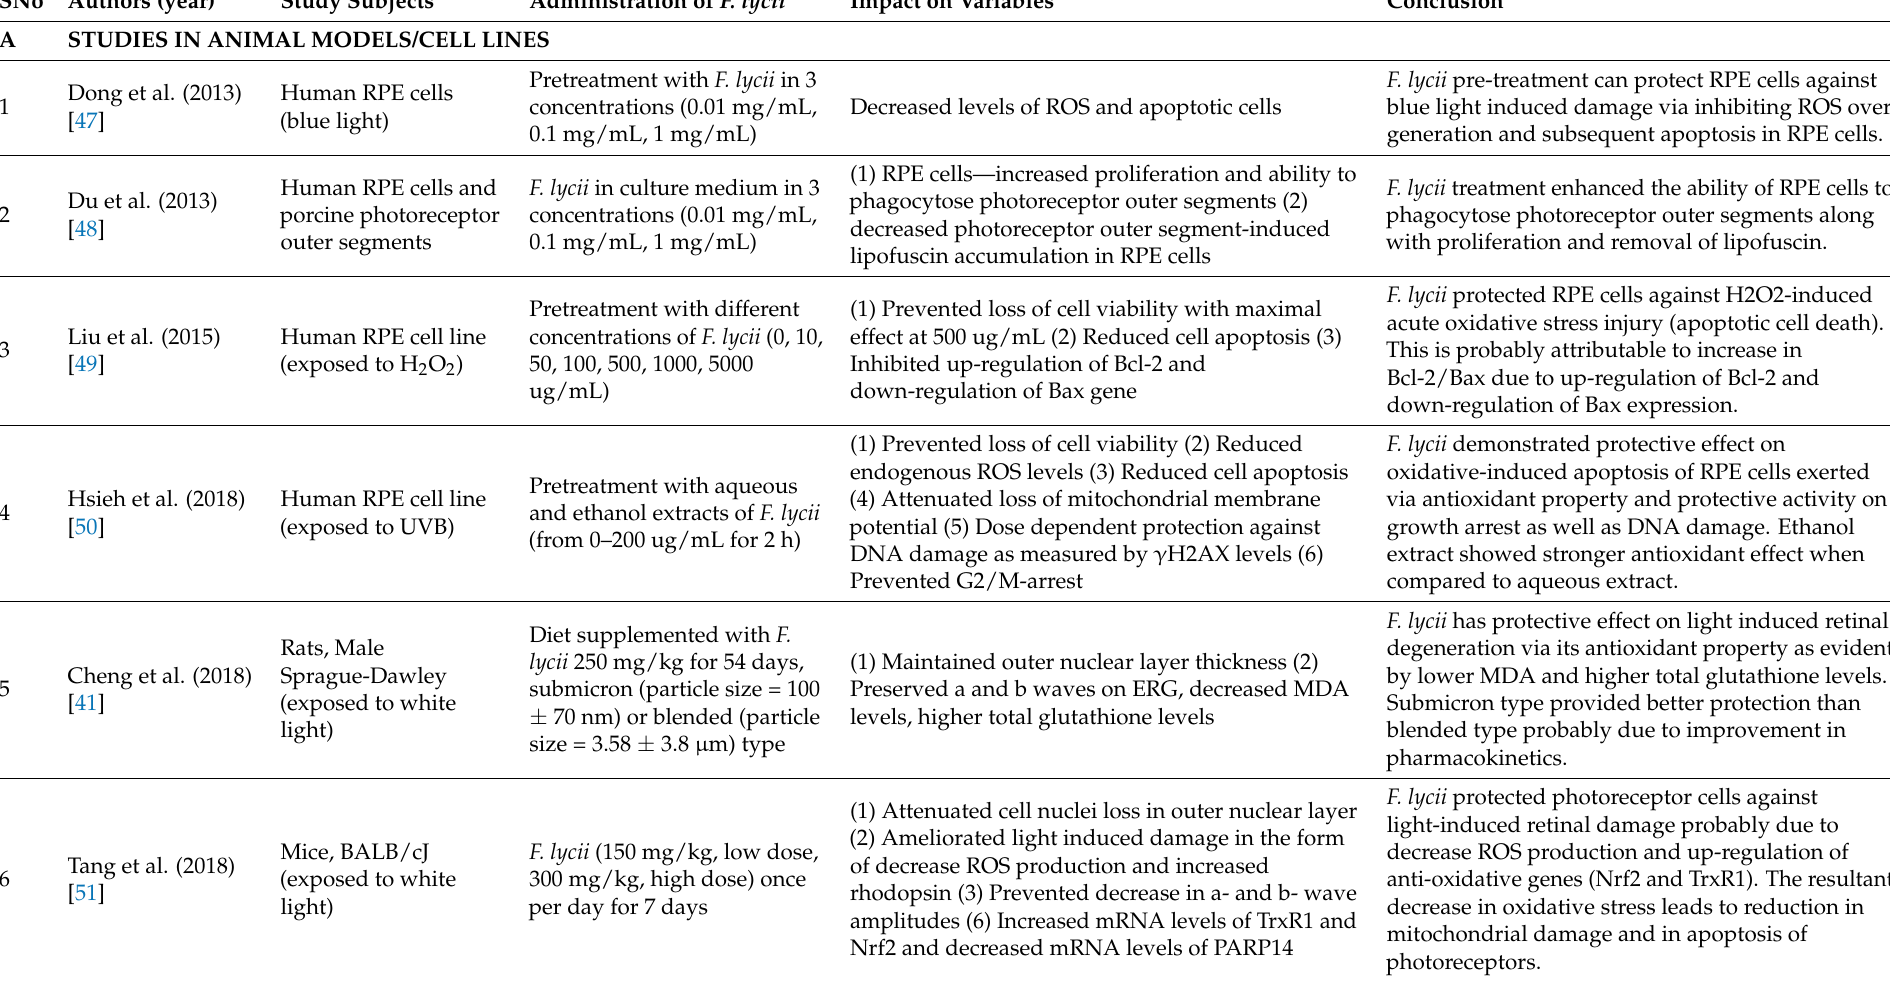
Table 2. List of studies that have evaluated F. lycii and age-related macular